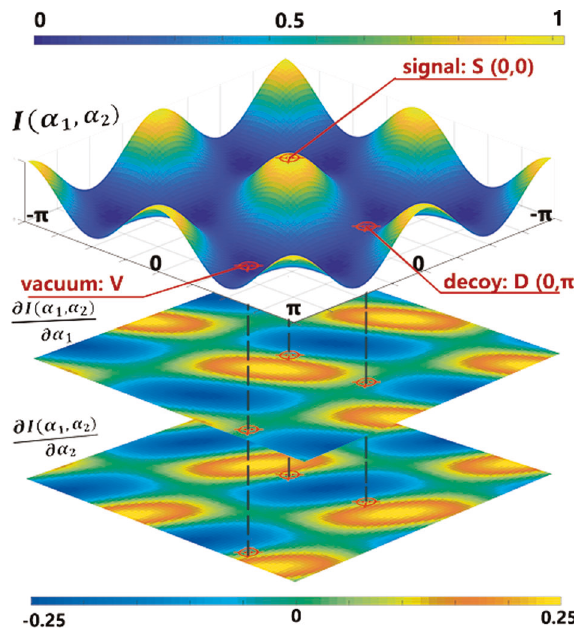
Fig. 5 The fi gure illustrates the output intensity and its partial derivatives. The upper surface plot illustrates and the two contour plots denote the two partial derivatives. The upper color bar belongs to the surface plot and the lower color bar belongs to the two contour plots. The ‘ S ’ , ‘ D ’ , and ‘ V ’ points are employed as the signal state, decoy state, and vacuum state respectively and the partial derivatives of the three points are all